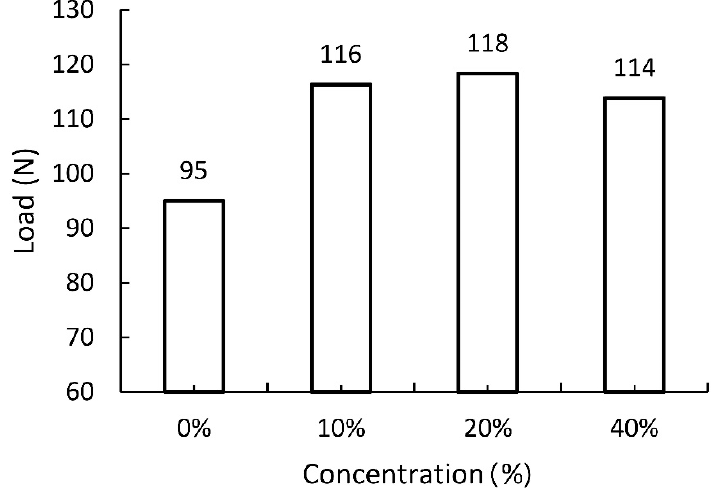
Figure 4. Tensile strength of paper impregnated with modified starch of varying concentration. Unimpregnated paper marked by 0% concentration.